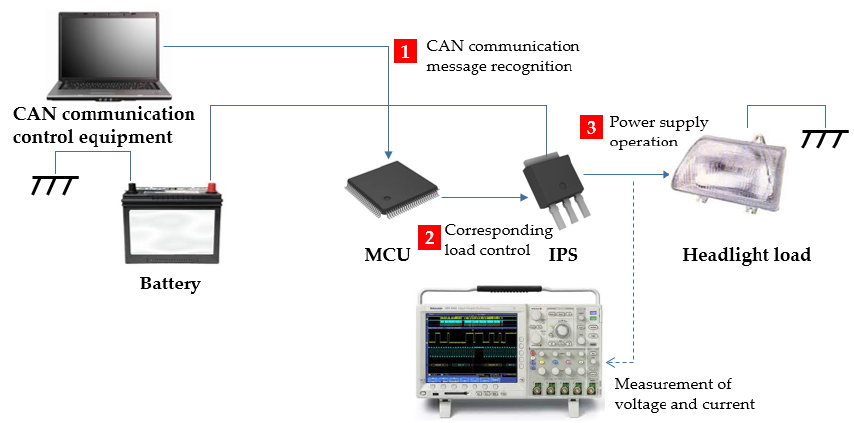
Figure 13. Schematic of the setup used for the driving test for each headlight load.